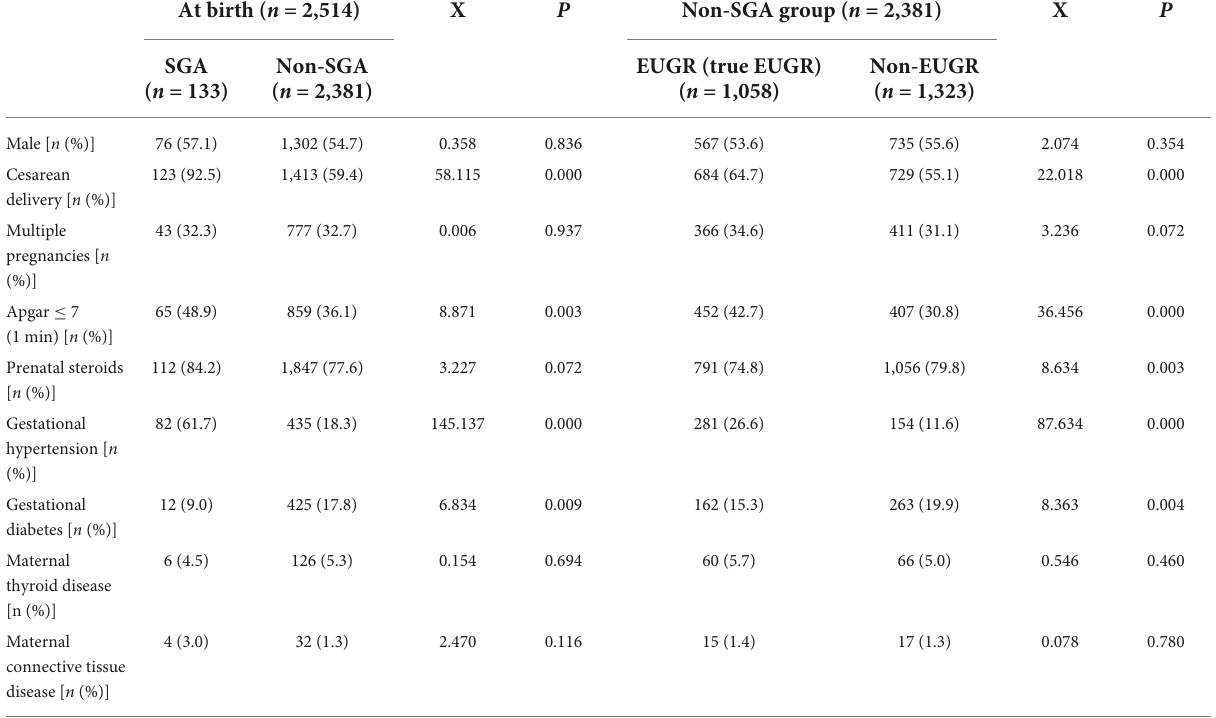
TABLE 1 Comparisons of obstetrical and neonatal characteristics of very preterm infants (VPI) between the groups. At birth ( n = 2,514) X P Non-SGA group ( n = 2,381) X P SGA Non-SGA ( n = 133) ( n = 2,381)